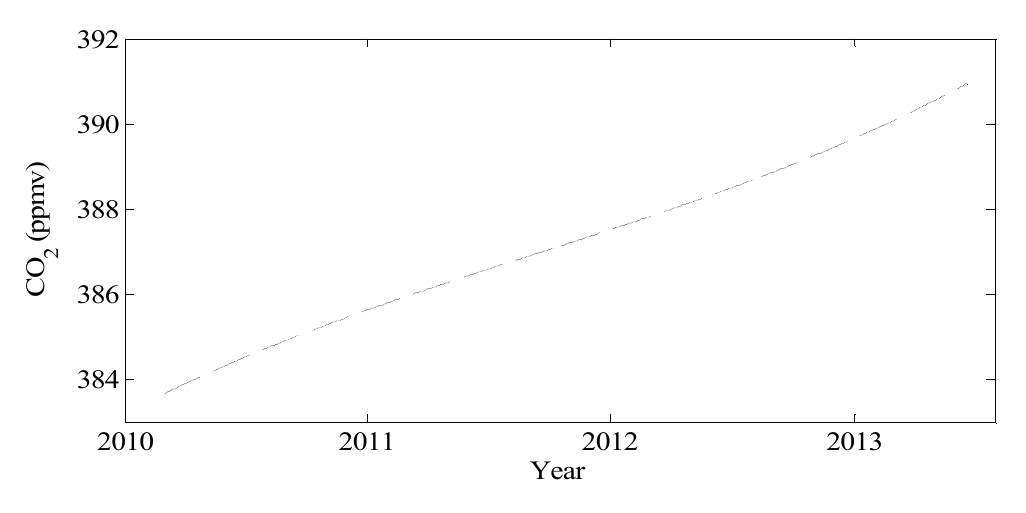
mole fraction at Zhongshan Station 2